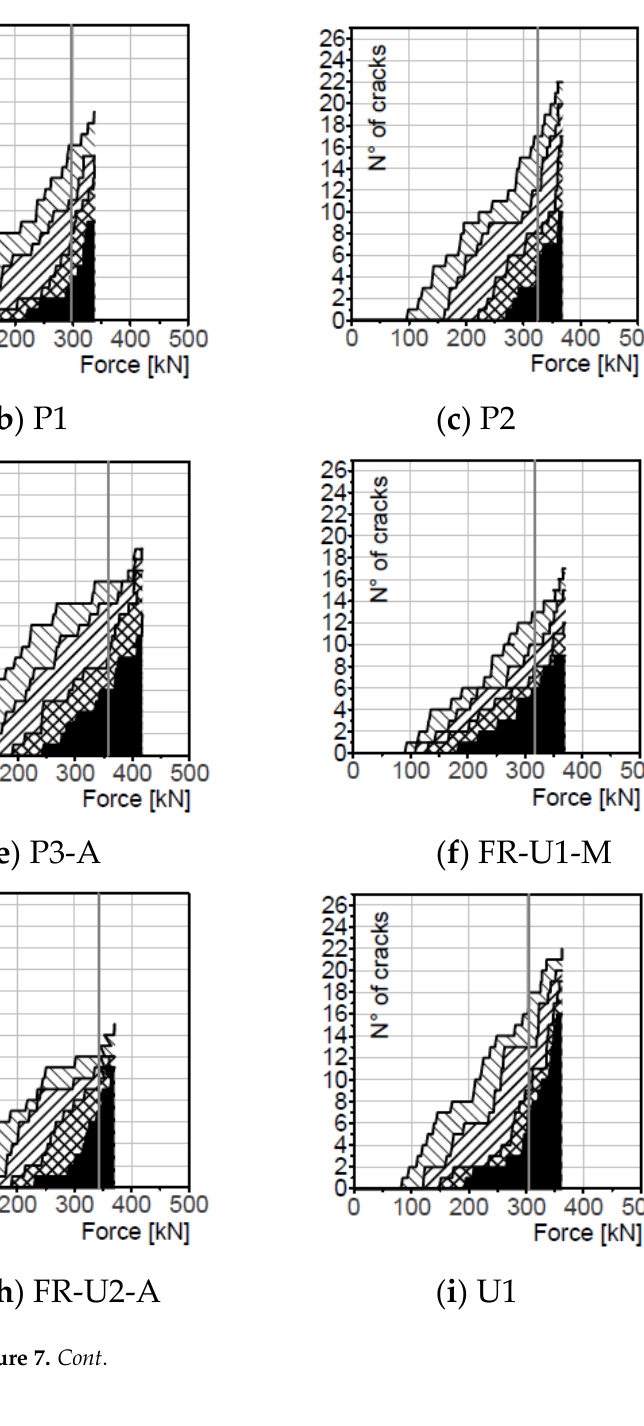
Figure 6. Crack patterns of all tested beams at the steel yielding load highlighted by the major principal strain.